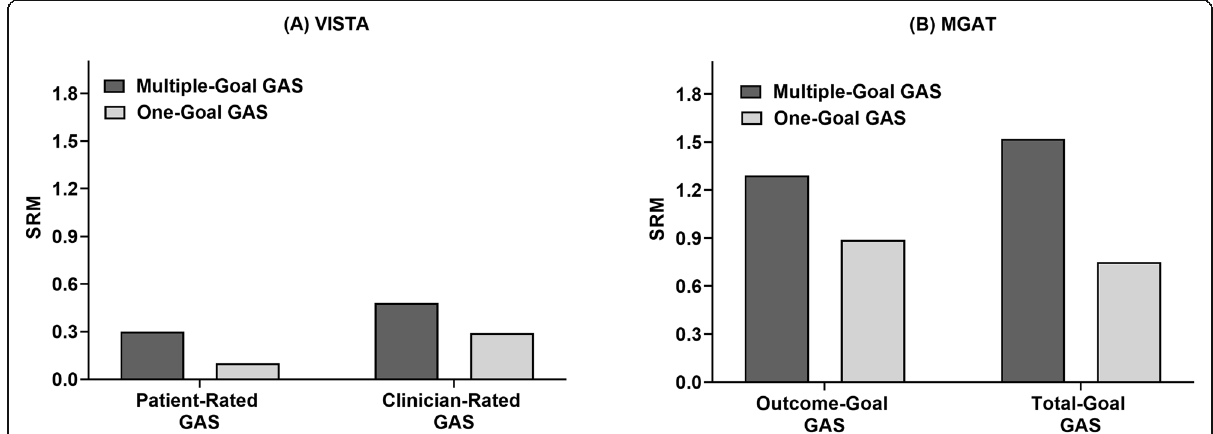
Fig. 2 Responsiveness gains and losses in relation to number of goals set in VISTA and MGAT